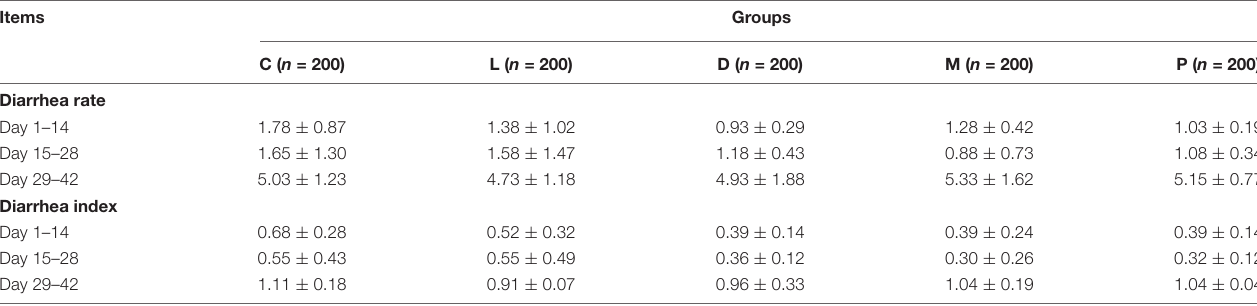
FIGURE 1 | Effects of different diet on intestinal morphology in weaned piglets. (A) Effects of different diets on epithelial morphology of the duodenum, jejunum, and ileum. (B) Effects of different diets on the villus length and crypt depth of the duodenum, jejunum, and ileum. C, Basal diet (Calcium carbonate + 1/1,000 g/kg of acidifier); L, 5/1,000 Calcium citrate diet + 1/1,000 g/kg of acidifier; D, 5/1,000 Calcium citrate diet + 1/1,000 g/kg of acidifier + 1/1,000 g/kg organic trace minerals; M, 5/1,000 Calcium citrate diet + 0.5/1,000 g/kg of acidifier + 1/1,000 g/kg organic trace minerals; P, 5/1,000 Multiple calcium diet + 1/1,000 g/kg of acidifier + 1/1,000 g/kg organic trace minerals. TABLE 3 | Effects of different calcium sources on diarrhea rate and diarrhea index of weaned